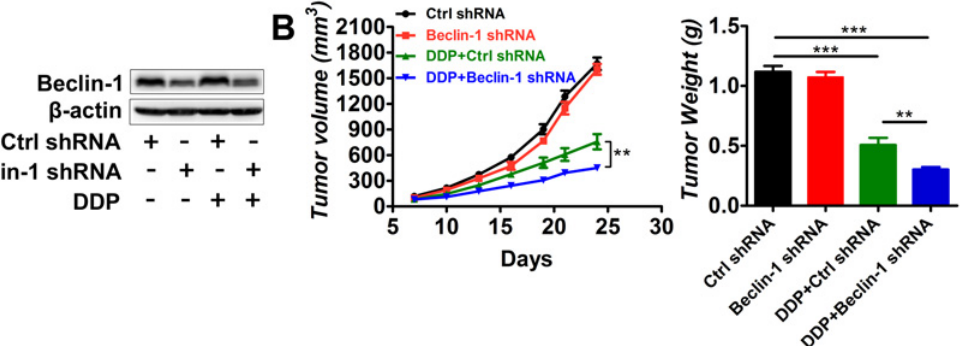
Fig 4. Suppression of Beclin-1 by shRNA decreases tumor growth in vivo . FaDu cells infected with lentiviral shRNA to Beclin-1or scrambled control were used for animal model building (n = 7 for each group). Established tumors were treated with DDP (5 mg/kg/6 days) or vehicle control. (A) Western blot of Beclin-1 suppression by shRNA. (B) Tumor volumes and tumor weights for each group. ** p < 0.01, *** p <